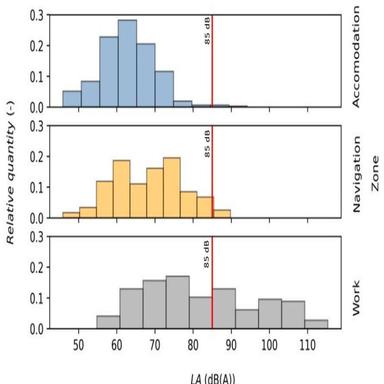
Distribution of total dB(A) levels for all the spectra analyzed classified by zone. The hearing protection limit at 85 dB(A) is represented with a vertical line.